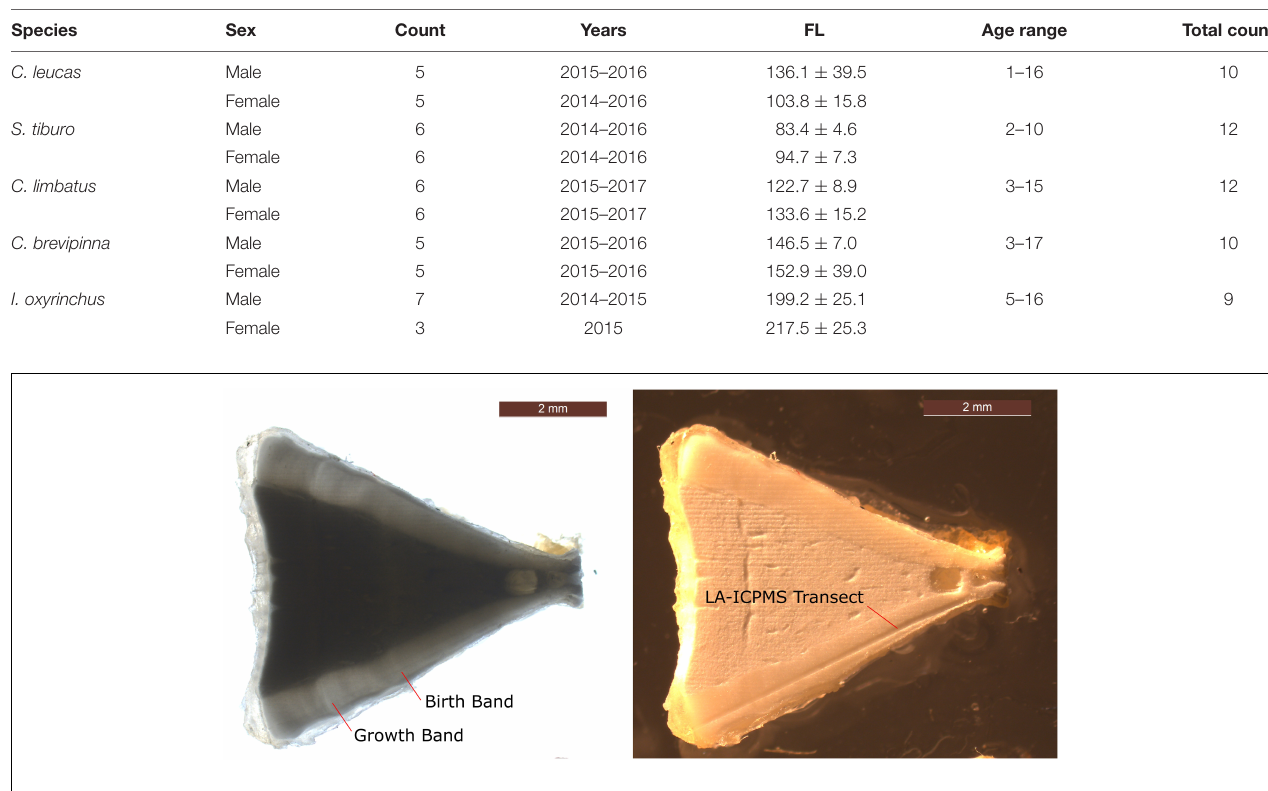
FIGURE 2 | Example of a sectioned C. leucas vertebral centrum, shown with transmitted light (left) for viewing growth bands (birth band and first growth band shown with red lines), and reflected light (right) for viewing LA-ICP-MS transect